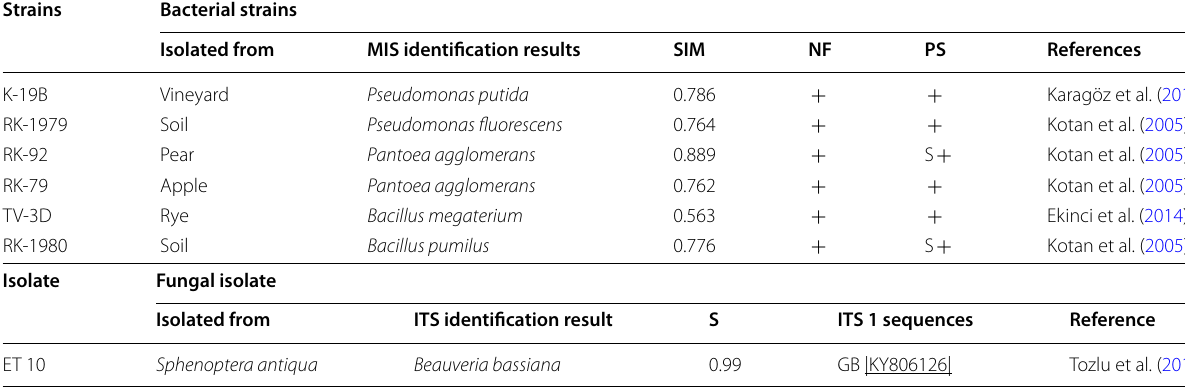
Molecular diagnosis of the fungus isolate (Beauveria bassiana -ET 10) used in the study was made and recorded in GenBank with underlined SIM similarity ındex, NF nitrogen fixation, PS phosphate solubilization ,